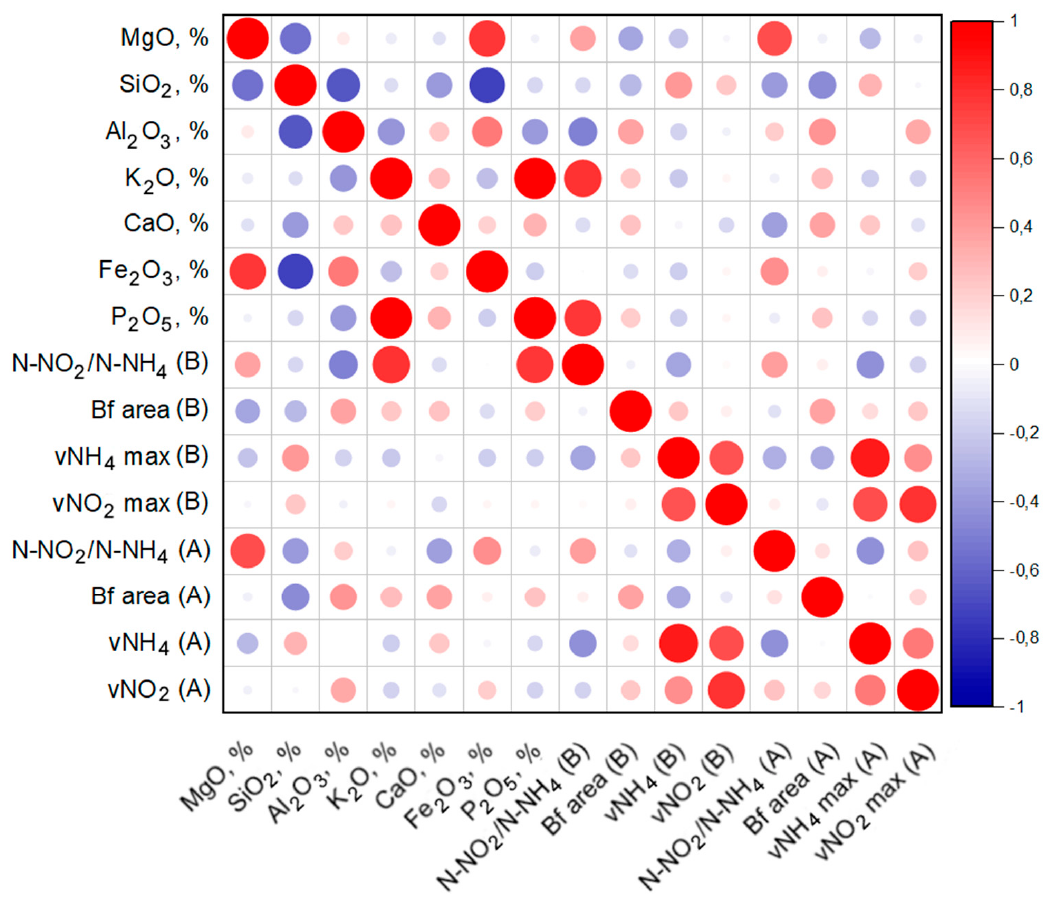
Figure 7. Correlation of N-NO 2 /N-NH 4 index, nitrogen consumption, and biofilm growth (Bf area) with the elemental composition of mineral carriers, p ≤ 0.5. A—bioaugmented microbial community, B—indigenous microbial community.